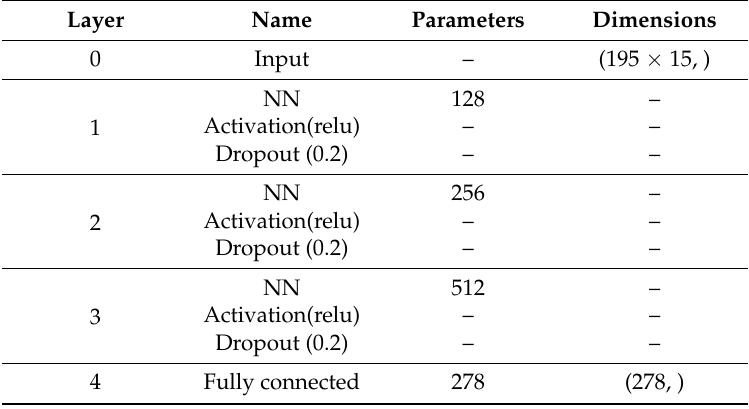
Table A1. Hyperparameters of the ANN when α =